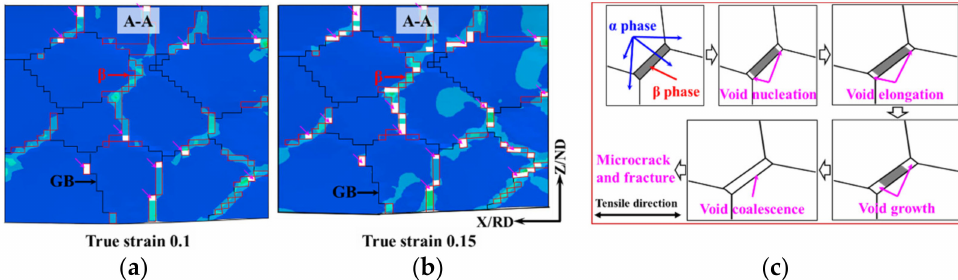
Figure 13. Simulated results and schematic of void evolution during hot tension of the TA15 sample (750 ◦ C–0.1 s − 1 ). ( a ) True strain 0.1; ( b ) true strain 0.15; ( c ) schematic of the void